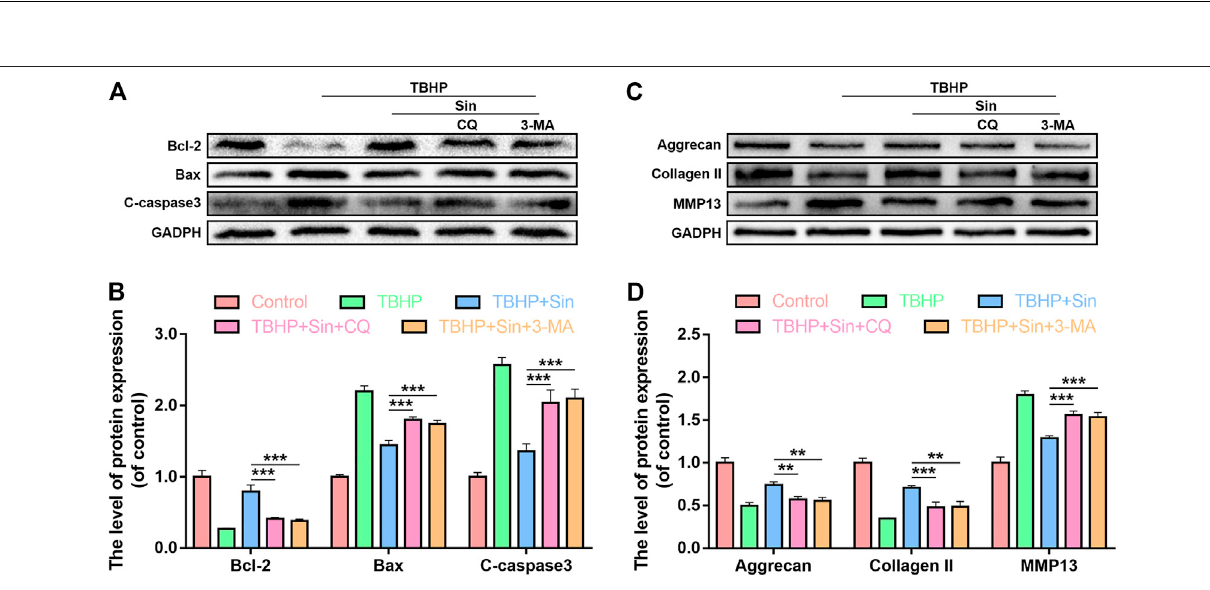
FIGURE 6 | Inhibition of autophagy offsets the bene fi cial effect of Sin. Chondrocytes were untreated, or treated with TBHP (30 μ M for 24 h) alone, or treated with Sin(40 μ Mfor24 h)andTBHP,ortreatedwithTBHPandSincombinedwithCQ(50 μ Mfor2 h)or3-MA(10 mMfor2 h). (A,B) Theresultsofwesternblottingshowthat the levels of Bcl-2, Bax and cleaved caspase 3 in chondrocytes treated above. (C, D) The results of western blotting show that the levels of Aggrecan, collagen II and MMP13 in chondrocytes treated above. The data are presented as the means ± SD (n (cid:1) 3); * p < 0.05, ** p < 0.01, and *** p <